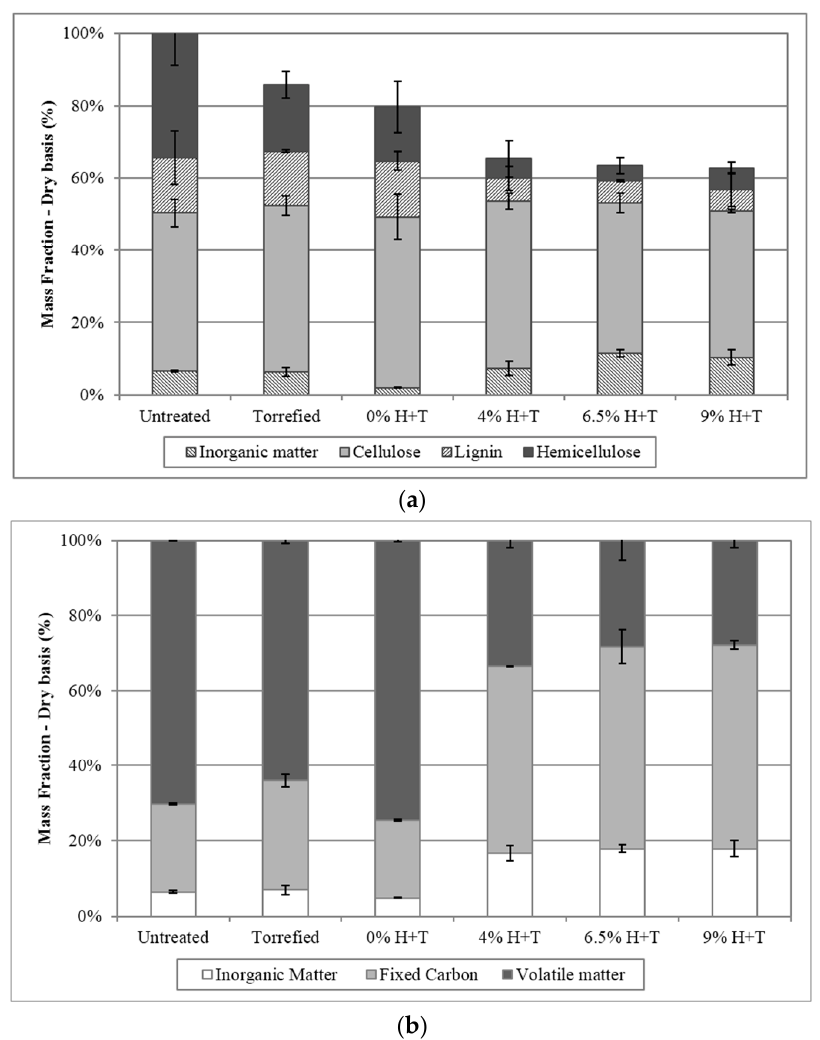
Figure 2. ( a ) Fiber and inorganic mass fractions of Phragmites australis after combined pretreatments with respect to the mass of the original raw biomass; ( b ) Proximate analysis composition of Phragmites australis after combined pretreatments; H + T: hydrolysis and torrefaction pretreatments.